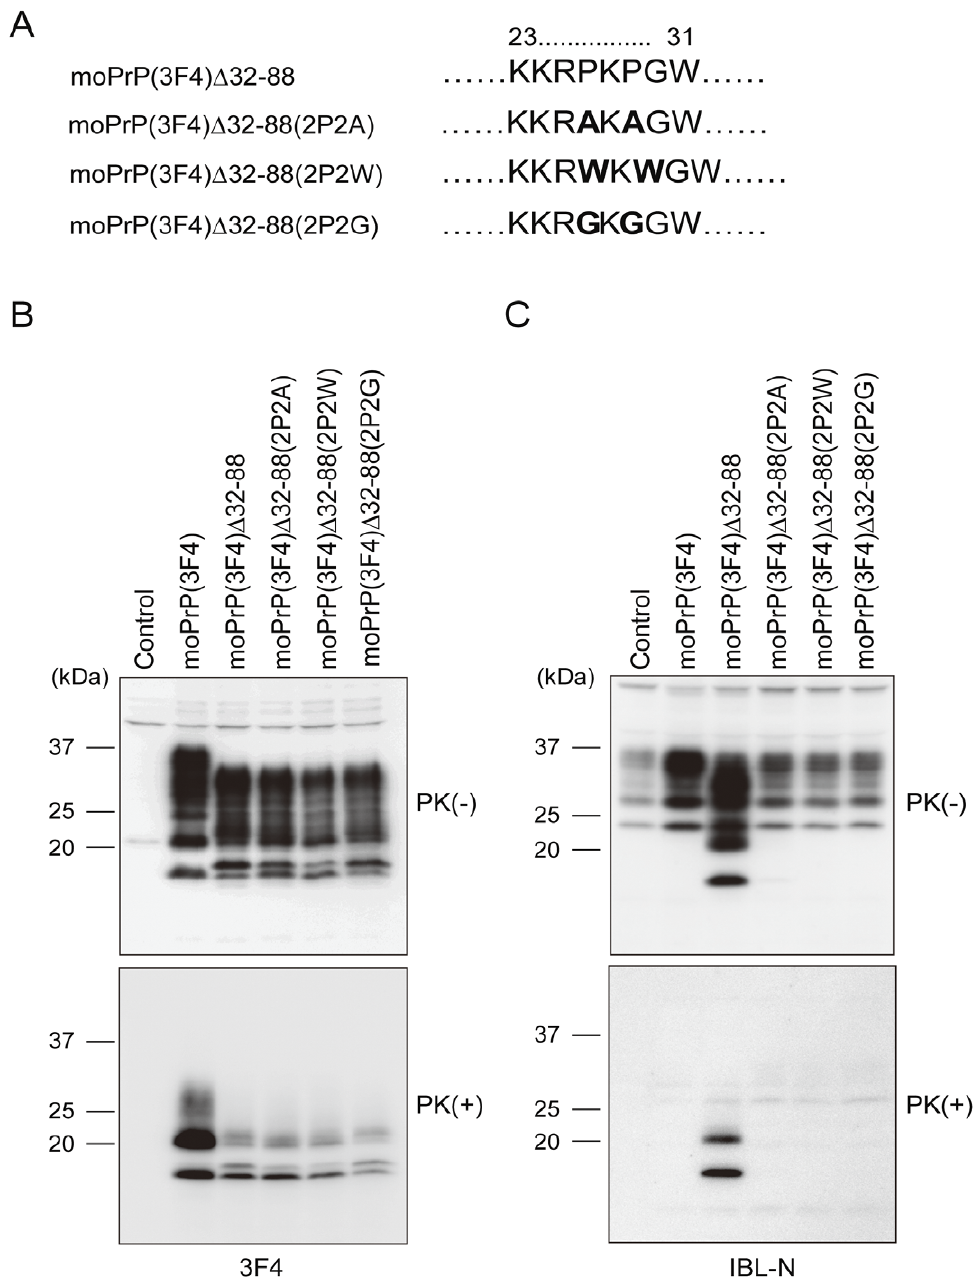
Figure 7. The pre-OR residues 23–31 with a substitution of the proline residues by tryptophan or glycine residues form a PK- resistant structure in prion-infected N2a cells. (A) Amino acid sequences of the pre-OR residues 23–31 in mutant proteins. Bold residues indicate substituted residues. (B) Western blotting of N2aC24L1-3 cells transfected with control pcDNA3.1( + ) and expression vectors encoding each mutant protein using 3F4 anti-PrP antibodies. The cell lysates were treated with PK at 5 m g/ml. All of the mutant proteins were converted into PK- resistant isoforms in N2aC24L1-3 cells, and all of the mutant isoforms, moPrP(3F4) Sc D 32–88, moPrP(3F4) Sc D 32–88(2P2A), moPrP(3F4) Sc D 32–88(2P2W) and moPrP(3F4) Sc D 32–88(2P2G), gave rise to similar doublet non-glycosylated and mono-glycosylated bands. (C) Since substitution of proline residues into alanine, tryptophan or glycine residues disrupted the IBL-N epitope, the PK-resistant pre-OR residues in these mutant proteins failed to be visualized by IBL-N anti-PrP antibodies. suggest that the effects of deletion of the OR region alone on Consequently, astrogliosis was detectable in tg(PrP D OR)/ Prnp 0/ 0 mice but not in tg(PrP D 32–93)/ Prnp 0/0 mice. The onset of conversion are limited, compared to those of deletion of residues foreleg paresis could be associated with the amounts of PrP Sc D OR 32–93 including the OR region. Therefore, the levels of PK- resistant PrP and prion infectivity were higher in the brains of or PrP Sc D 32–93 in the brain or in the spinal cord. However, the tg(PrP D OR)/ Prnp 0/0 mice than in tg(PrP D 32–93)/ Prnp 0/0 mice. exact mechanism underlying the foreleg paresis remains unknown.